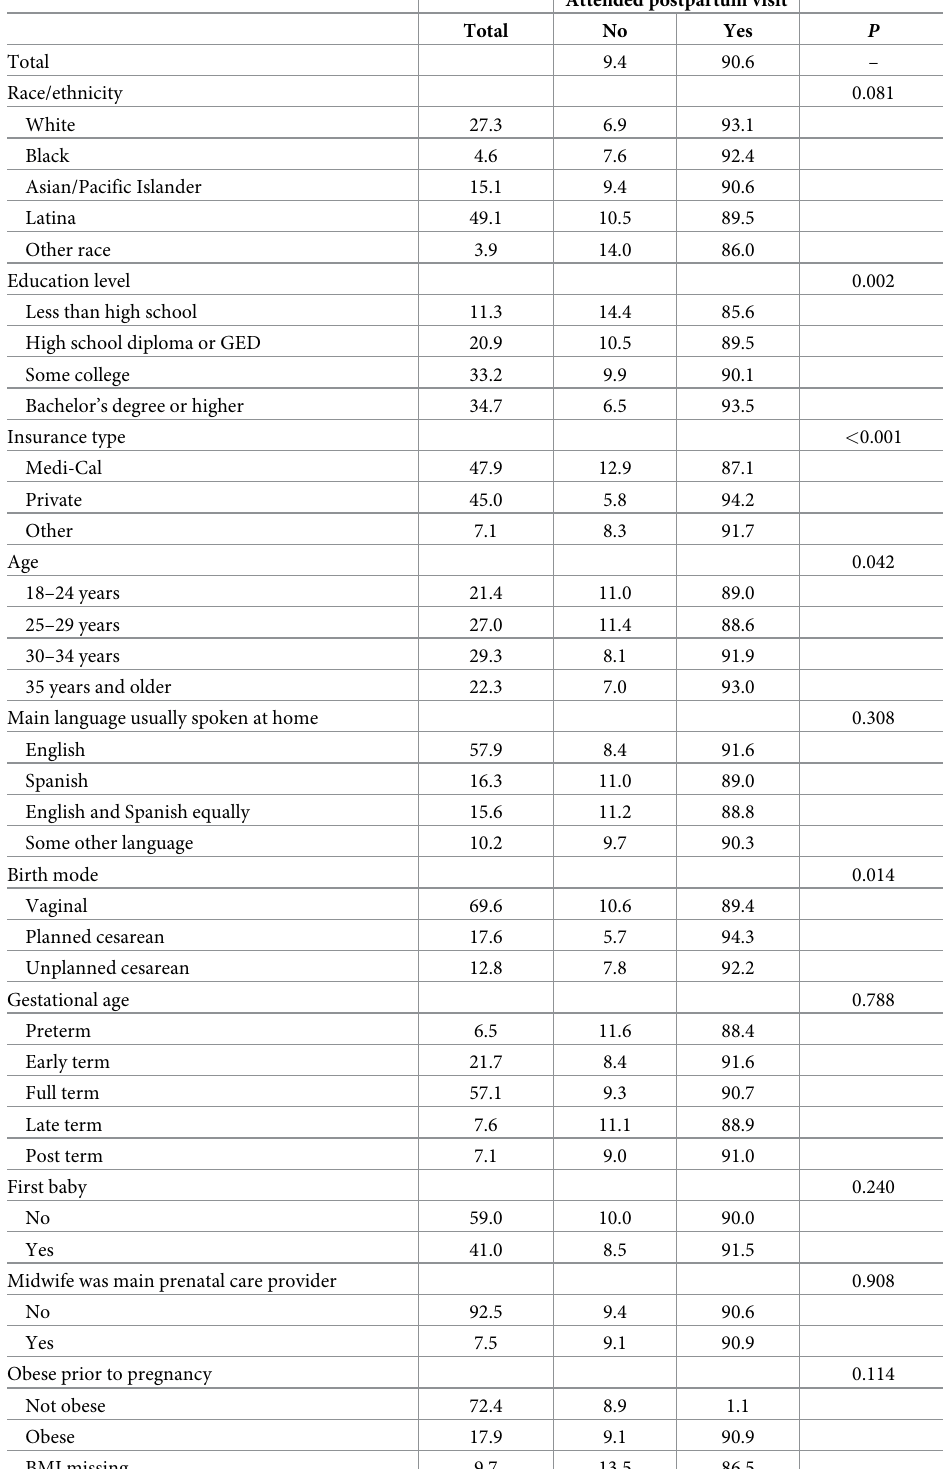
Table 1. Characteristics of women in the Listening to Mothers California survey overall and by postpartum visit attendance (N =